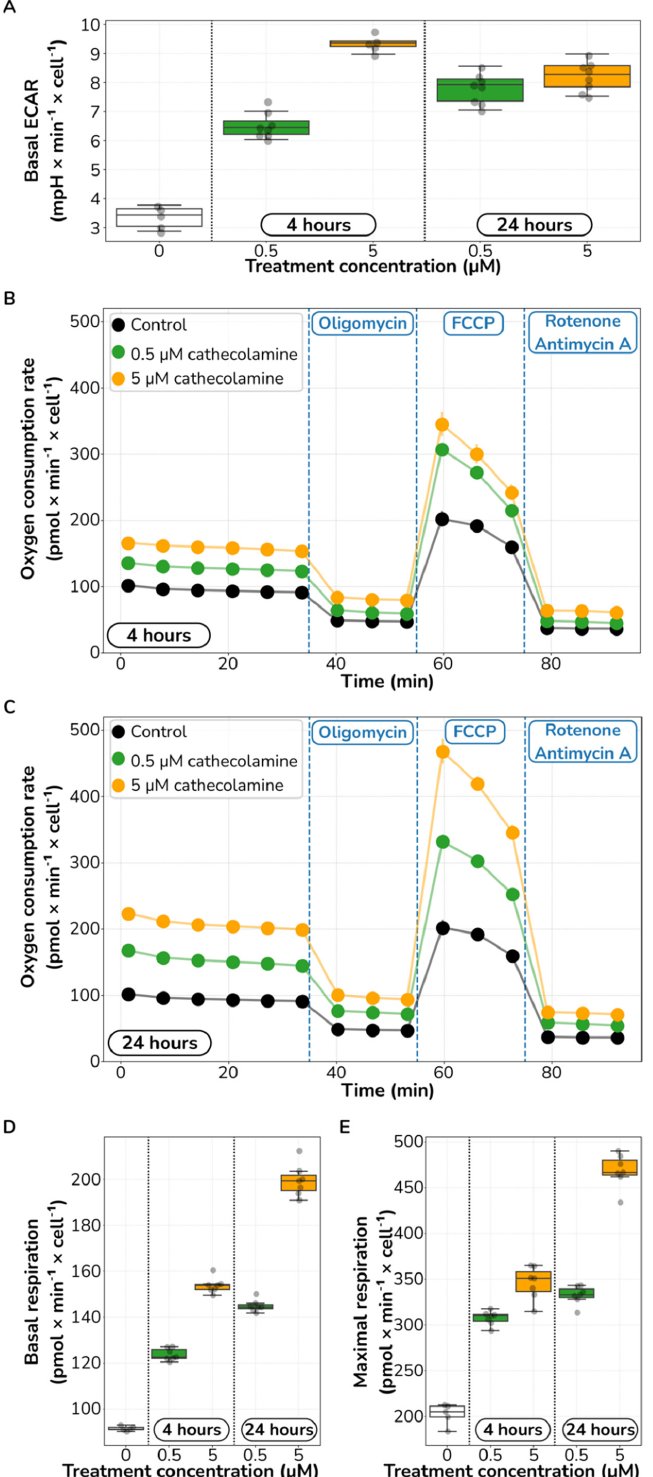
Figure 3. Catecholamine stimulation increases glucose consumption and aerobic respiration . ( A ) Basal levels of extracellular acidification rate (ECAR) in HUVECs stimulated for 4 and 24 h with different catecholamine concentrations. ( B , C ) Oxygen consumption rate (OCR) time profiles in HUVECs stimulated for 4 h ( B ) and 24 h ( C ) with different catecholamine concentrations. FCCP, carbonyl cyanide- p -trifluoromethoxyphenylhydrazone. ( D , E ) Effect of treatment on basal ( D ) and maximal ( E ) OCR in